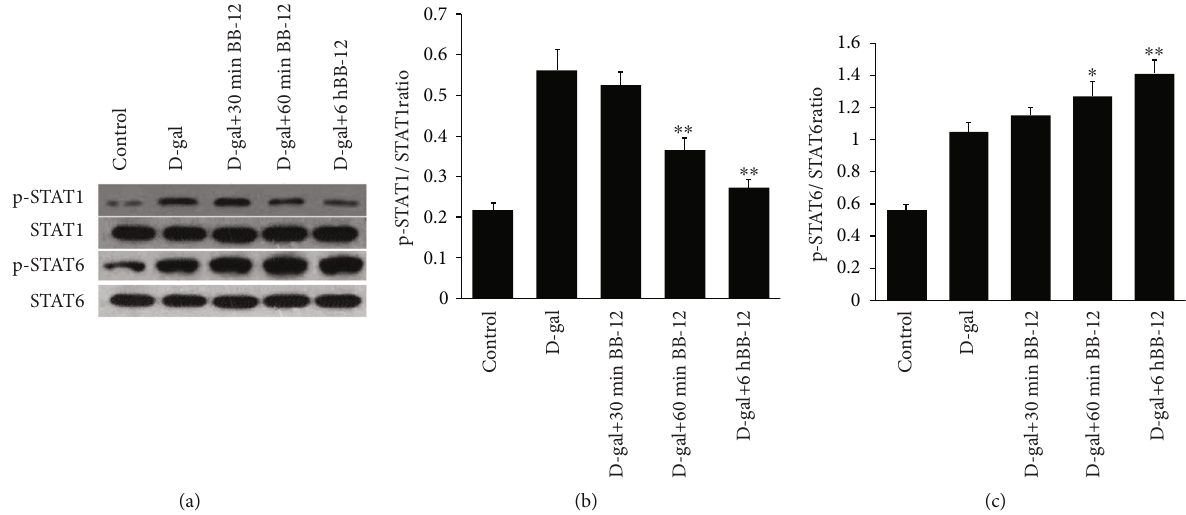
Figure 7: E ff ects of BB-12 on STAT1 and STAT6 expression levels. (a) Western blot analysis of p-STAT1, STAT1, p-STAT6, and STAT6 protein expression levels. p-STAT1 expression decreased in the group after treatment with BB-12 compared with that in D-gal group. However, with the increase in BB-12 treatment time, the p-STAT6 expression levels were gradually higher in the D-gal+30min BB-12, D- gal+60min BB-12, and D-gal+6h BB-12 groups compared with those in the D-gal group. β -Actin was used as the internal control. (b) p- STAT1/STAT1 ratios and (c) p-STAT6/STAT6 ratios. ∗ P < 0 : 05 or ∗∗ P < 0 : 01 vs. the D-gal group; n = 3